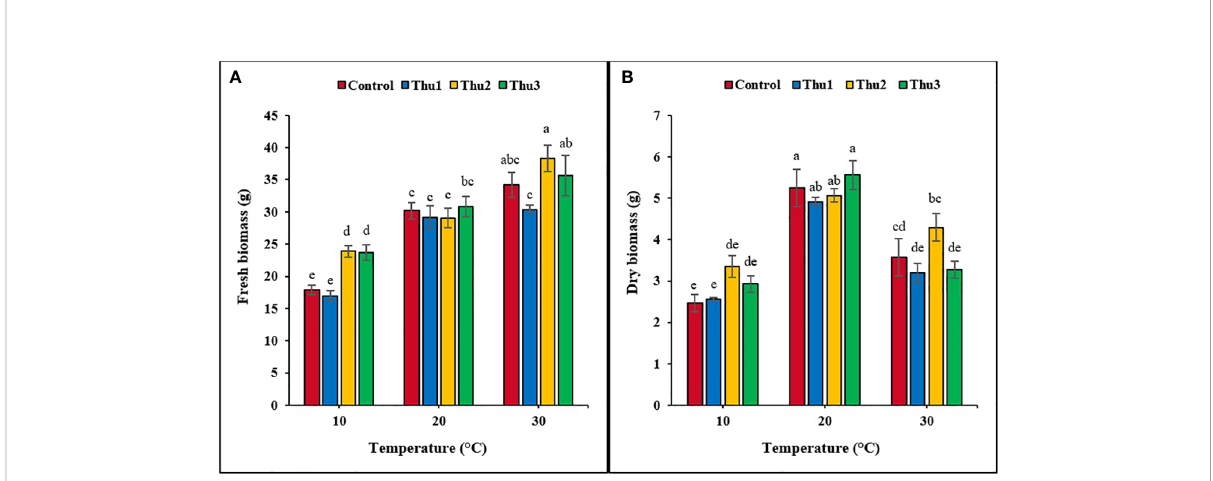
FIGURE 9 Effects of temperature and Th17 concentrations on canola fresh (A) and dry (B) biomass. Thu1: 10 -7 M Th17, Thu2: 10 -9 M Th17, Thu3: 10 -11 M Th17. Each bar represents mean ± standard error (n=8). Means with the same letters are not signi fi cantly different ( p <